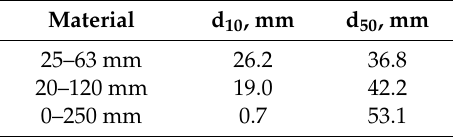
Figure 8. Gradation of materials tested by the NGI (redrawn according to NGI (1999) [21]). Table 1 gives the approximate values of effective particle size (d 10 ) and mean particle size (d 50 ) obtained from the gradation curves. Table 1. d 10 and d 50 of test materials